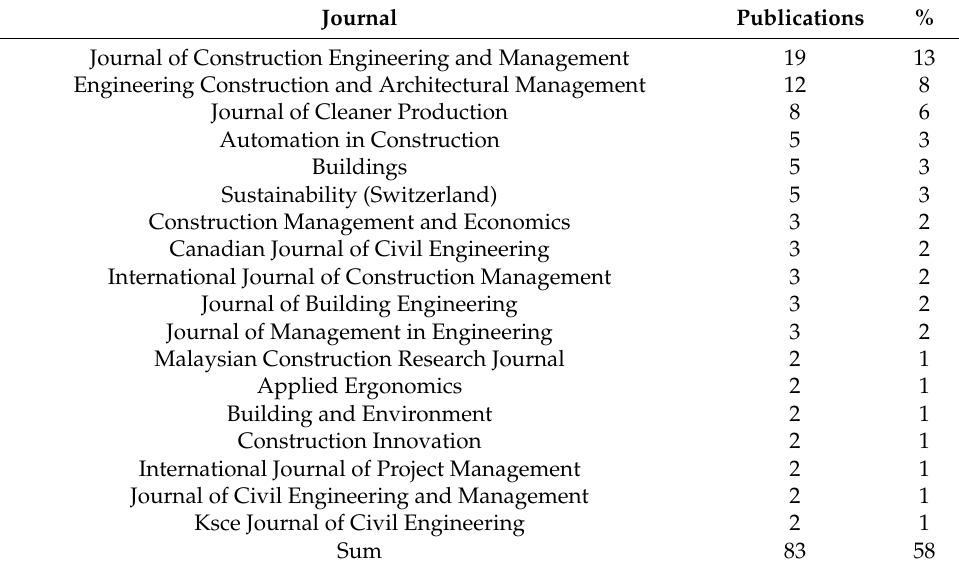
Table 1. Journals with no fewer than 2 publications of RM in PC.